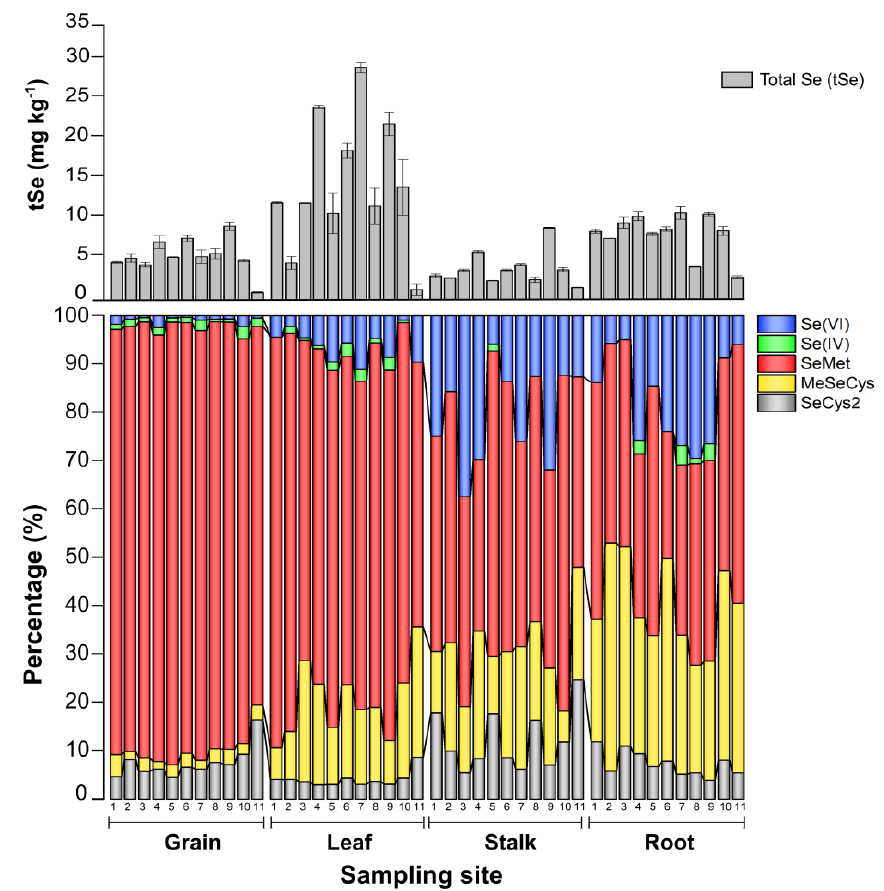
Figure 4. Distribution of Se enzyme-soluble species and tSe in each maize organ.